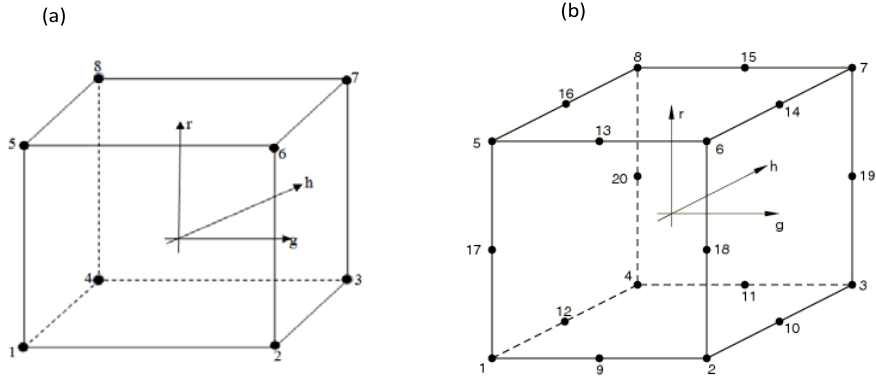
Figure 1. Solid hexahedral elements: ( a ) 8-nodes; ( b ) 20-nodes [19].